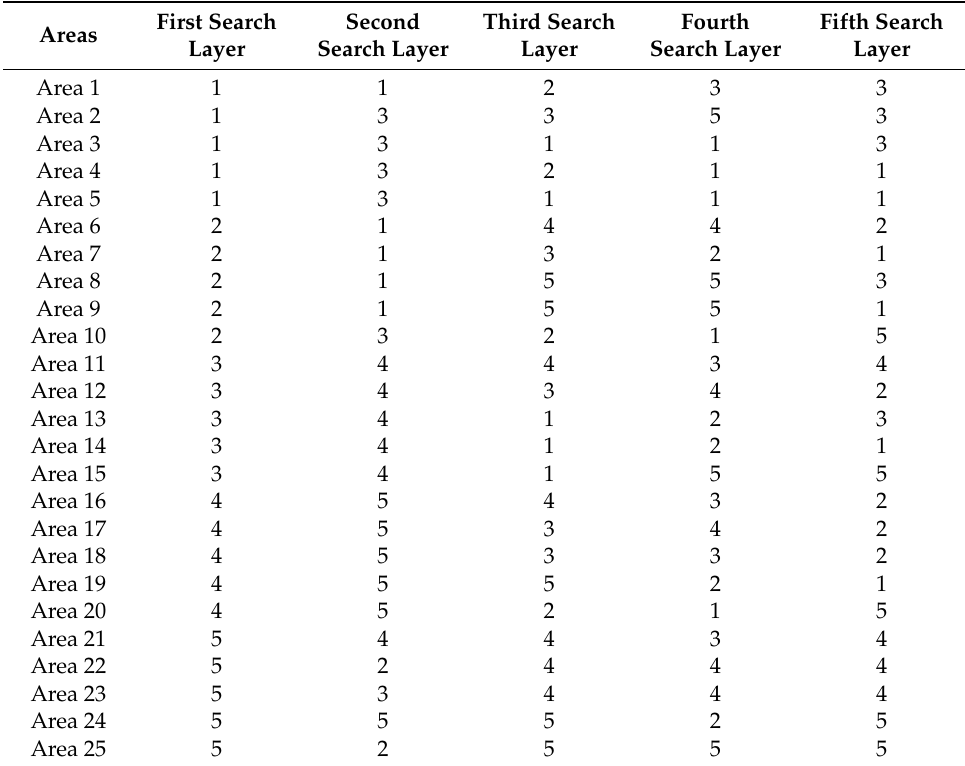
Table 2. Subregion allocation at each search